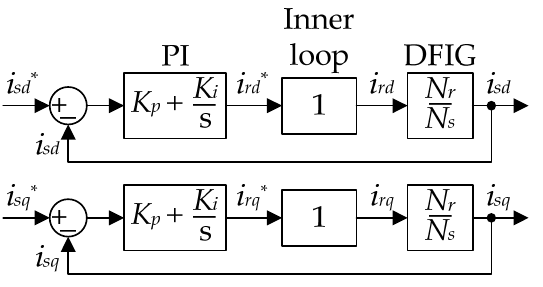
Figure 5. Block diagram of the simplified control model of the proposed decoupled control.